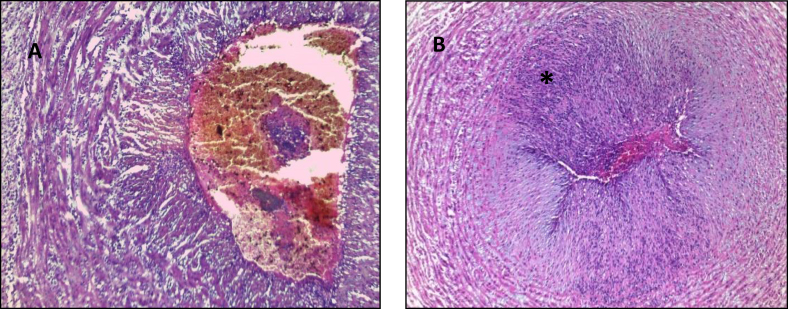
Staging of acute funisitis: Fetal Inflammatory Response (HE) A. Umbilical phlebitis shows amniotropic migration of fetal neutrophils into the muscle layer of the umbilical vein. Umbilical phlebitis represents stage 1 fetal inflammation; B. Umbilical arteritis is a stage 2 fetal inflammatory response. ∗ Redline RW and col classification.